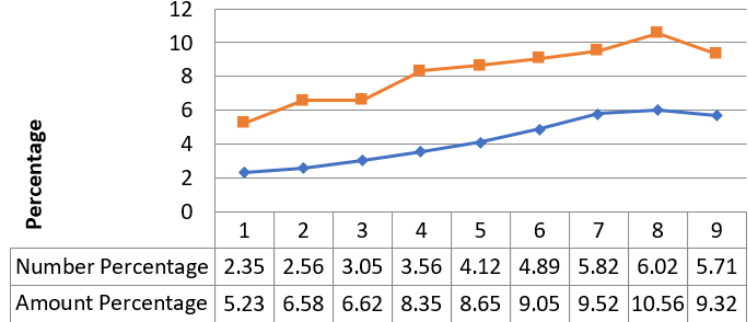
Figure 2. The trends of model Figure 2 . The trends of model testing